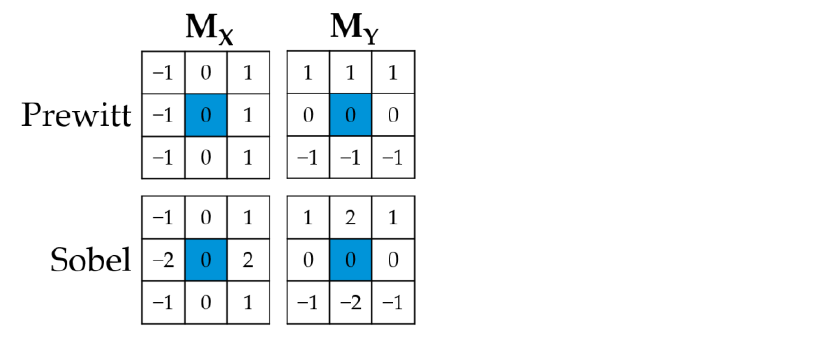
density visualized as the grey area in the figure, where, respectively, the grey/white areas represent the interpreted structure/void regions of the continuous design domain, which is represented by the 3 × 3 number